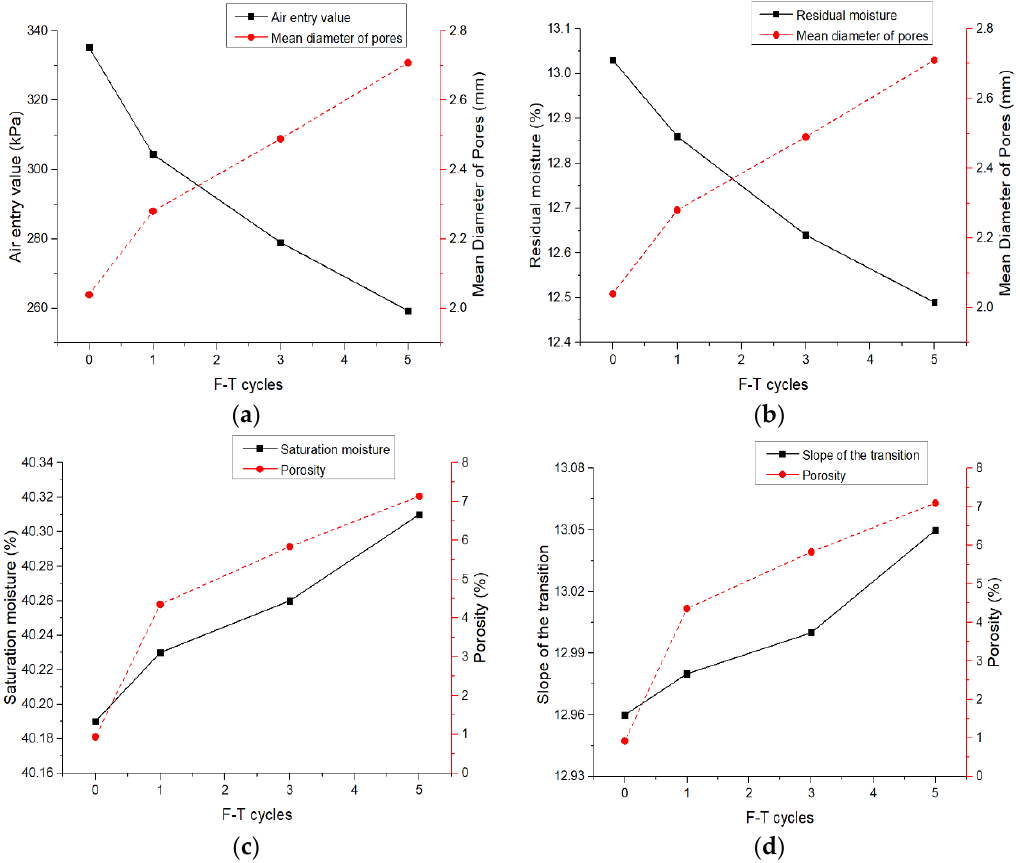
Figure 6. Changes in pore parameters and SWCC characteristic parameters after different F–T cycles. ( a ) AEV and mean diameter with F–T cycles; ( b ) Residual moisture and mean diameter with F–T cycles; ( c ) Saturation moisture and porosity with F–T cycles; ( d ) s 1 and porosity with F–T cycles.